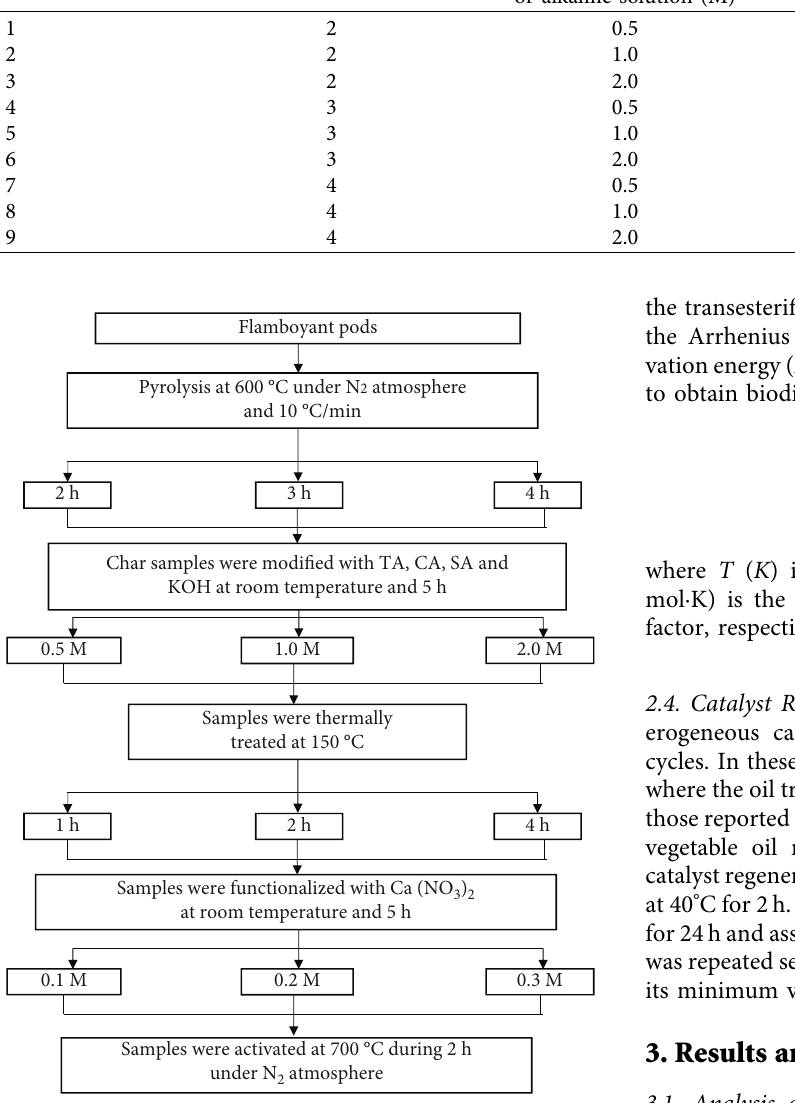
Table 1: Taguchi L 9 experimental design used for the preparation of alkaline and acidic heterogeneous catalysts from flamboyant pods. Catalyst sample